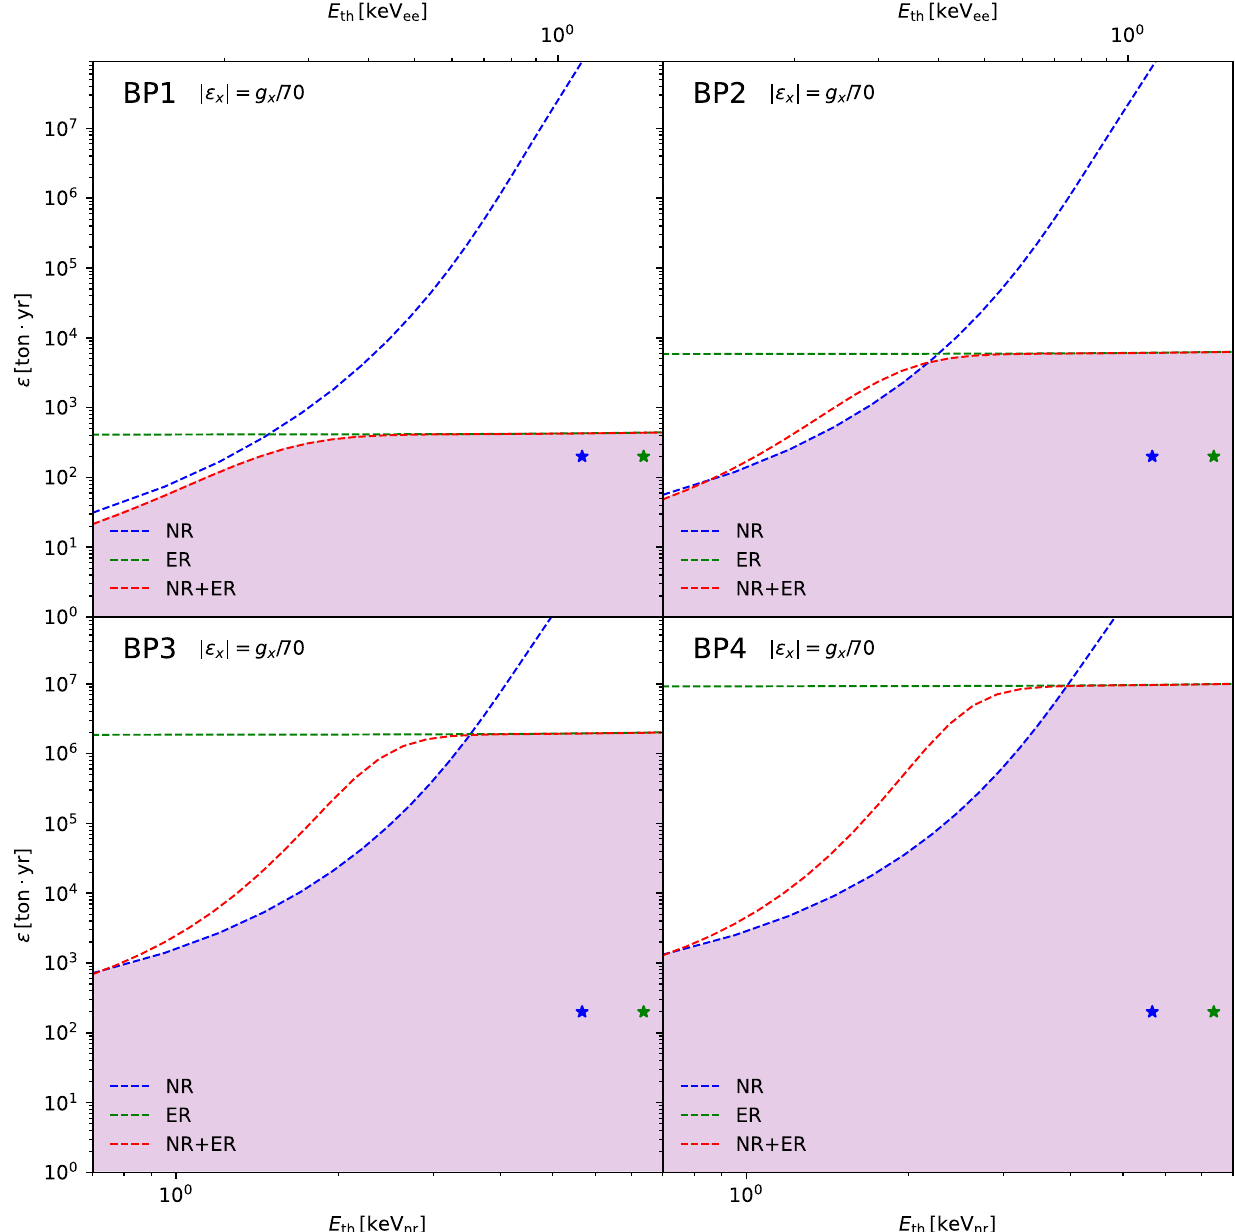
Fig. 11 DARWIN discovery region for searches based on NR (blue dashed line) ER (green dashed line) and NR+ER (red dashed line) as a function of the exposure ( (cid:8) ) and energy threshold ( E th ) for each bench- mark point of Table 1. In the area above each of these lines, the experi-